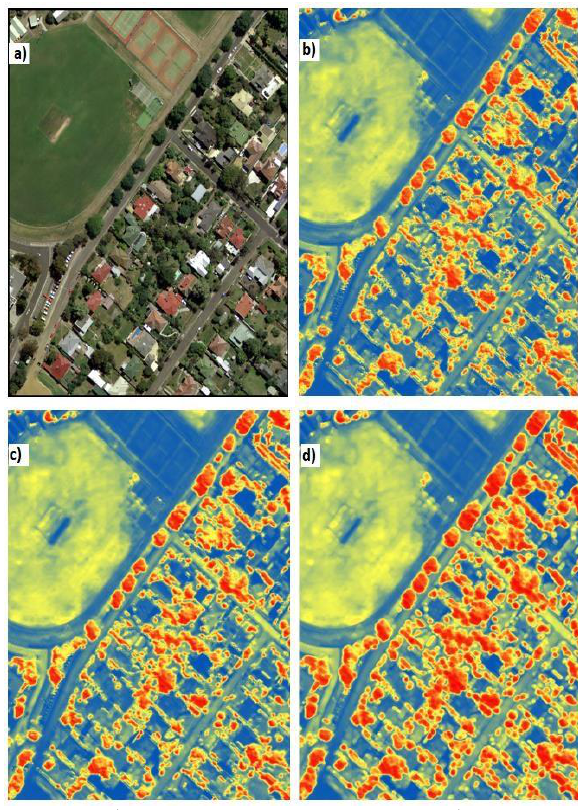
Figure 6. a) Original RGB image of test region b) Probability heatmap of tree presence resulted from CNN with values between 0 to 1 (blue to red respectively) c) Smoothed heatmap